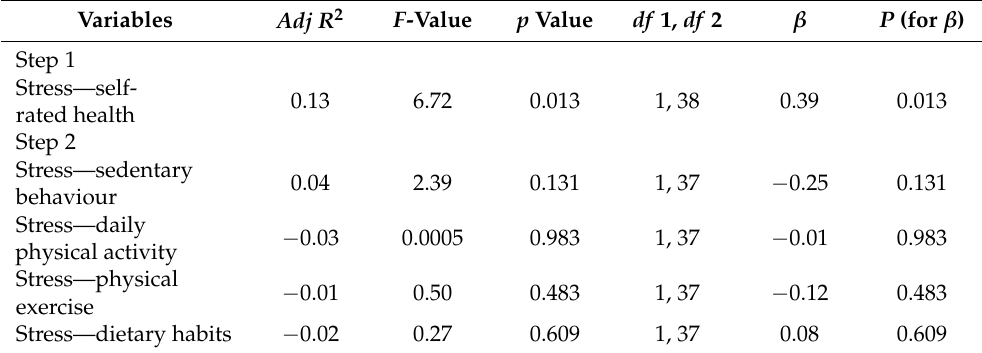
Table 7. Simple regression analyses; participants with three or four of the requested diagnoses (steps 1 and